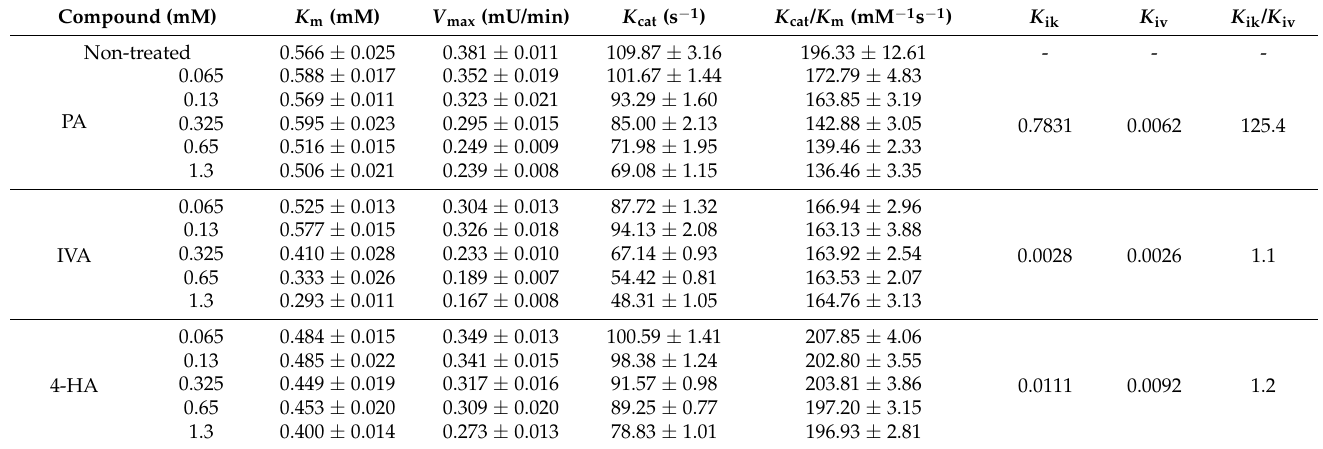
Table 1. Effect of PA, IVA, and 4-HA on kinetic parameters of thrombin.